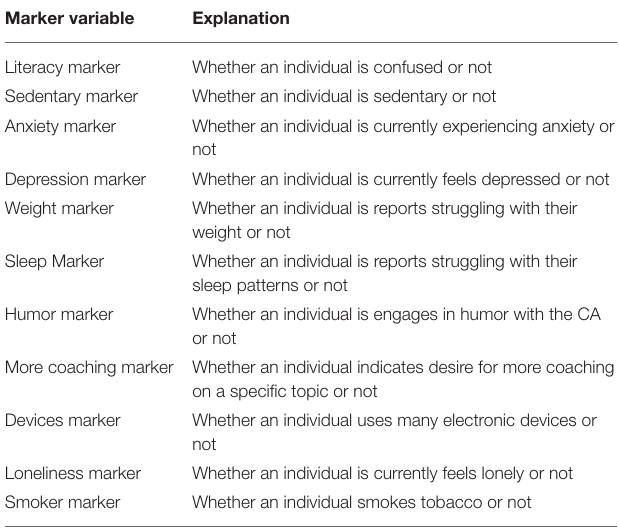
TABLE 5 | Summary selection of marker